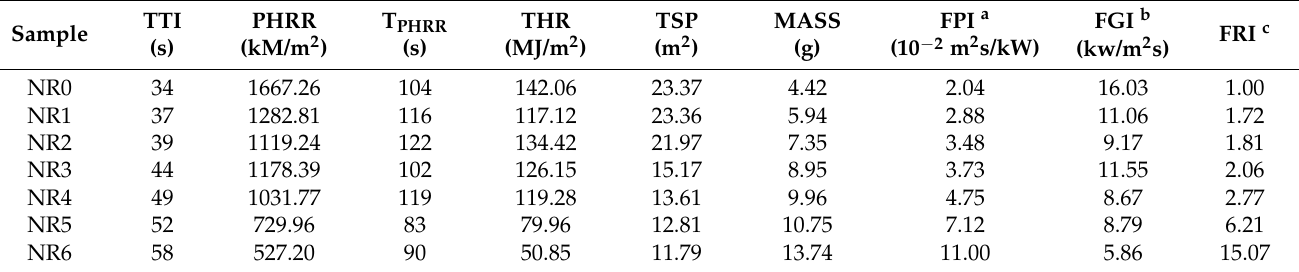
Table 3. Cone calorimetry test data for various